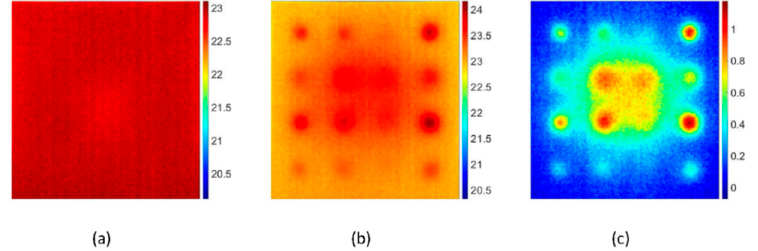
Figure 5. Experimental pulsed thermal images on the front surface of the flat ‐ bottomed holes sample after pre ‐ processing, ( a ) thermal image at time 0 s before the application of pulse heating, ( b ) thermal image at time 0.1 s after the deposition of heat flux where defect exhibit the higher signal ‐ to ‐ background contrast and ( c ) thermal image which is result of subtracting Figure 5a from Figure 5b [Frequency = 50 Hz, number of frames = 250, truncation window = 5 s]. Temperature scales are in degree Celsius.